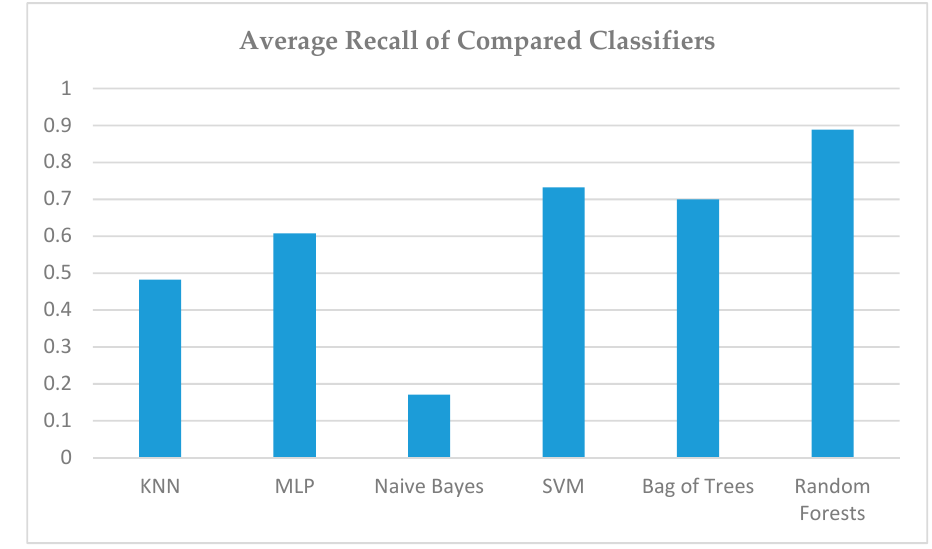
Sensors 2019 , 19 , x FOR PEER REVIEW Figure 11. Comparison of Recall of all Classifiers. Figure 11. Comparison of Recall of all Classifiers.